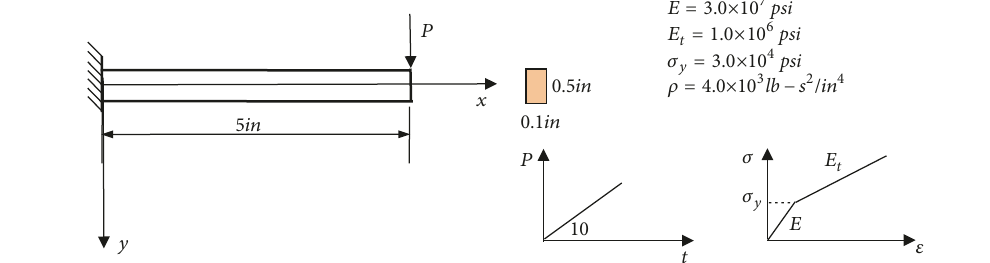
Figure 15: Cantilever beam subject to joint load at the free end.